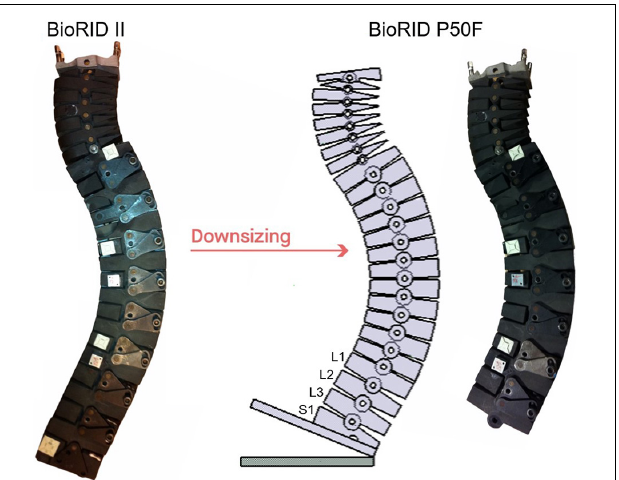
FIGURE 1 | The spine of the BioRID P50F prototype was made by removing two lumbar vertebrae (L4 and L5) from the BioRID II spine and the height of the sacral vertebra (S1) was reduced by 20